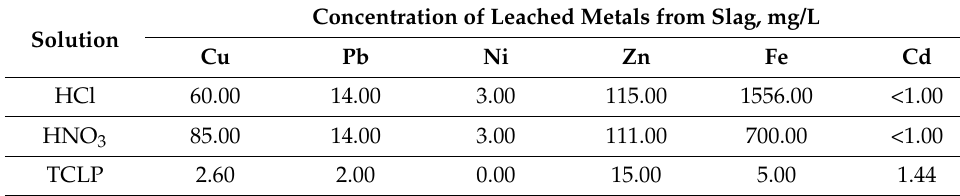
Table 4. Metal concentration in slag after leaching in different